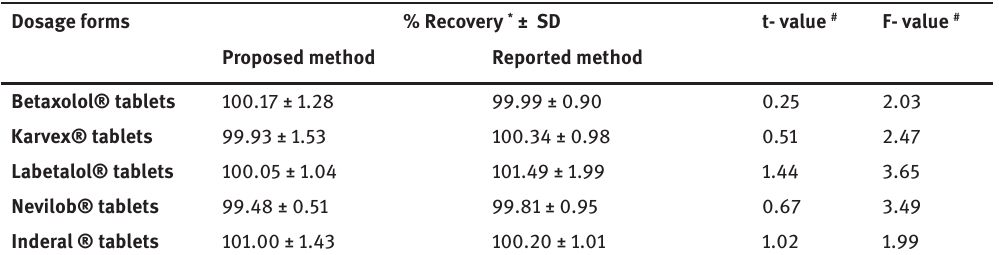
Table 5: Analysis of commercial tablets containing the investigated β- blockers by the developed and reported methods [13 – 16]. Dosage forms